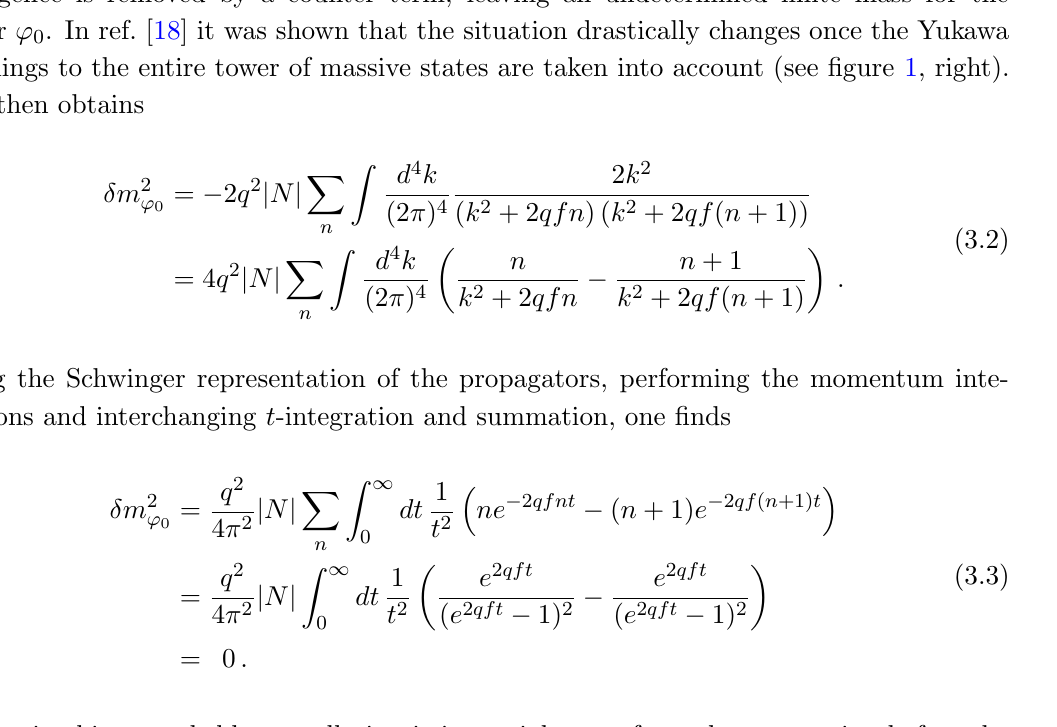
Figure 1 . One-loop contributions to the scalar mass term. Left: contribution of right: contributions of the massive fermions (cid:9) n;j and (cid:9) n +1 ;j